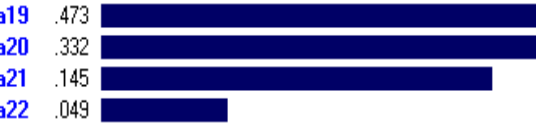
Fig. 8. The evaluation for category C